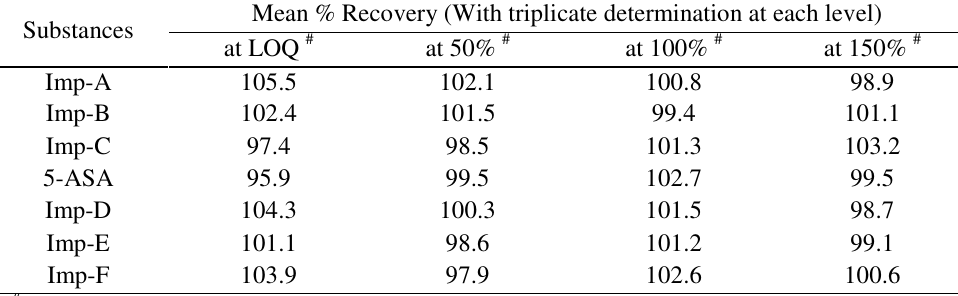
Table 6. Accuracy